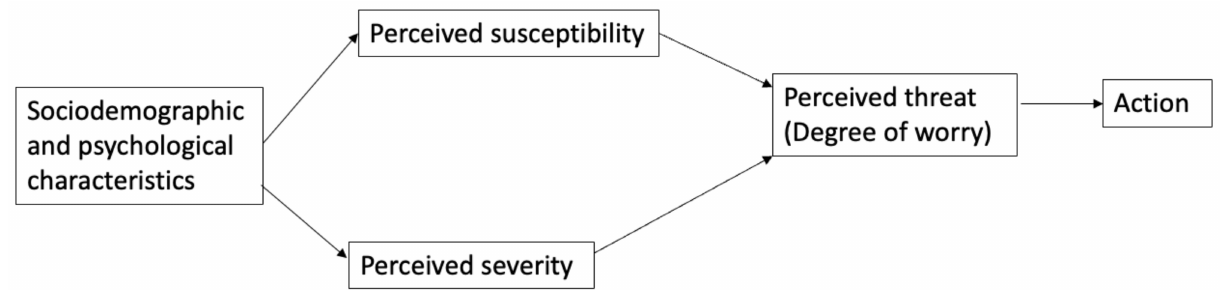
Figure 1. Adapted Health Belief